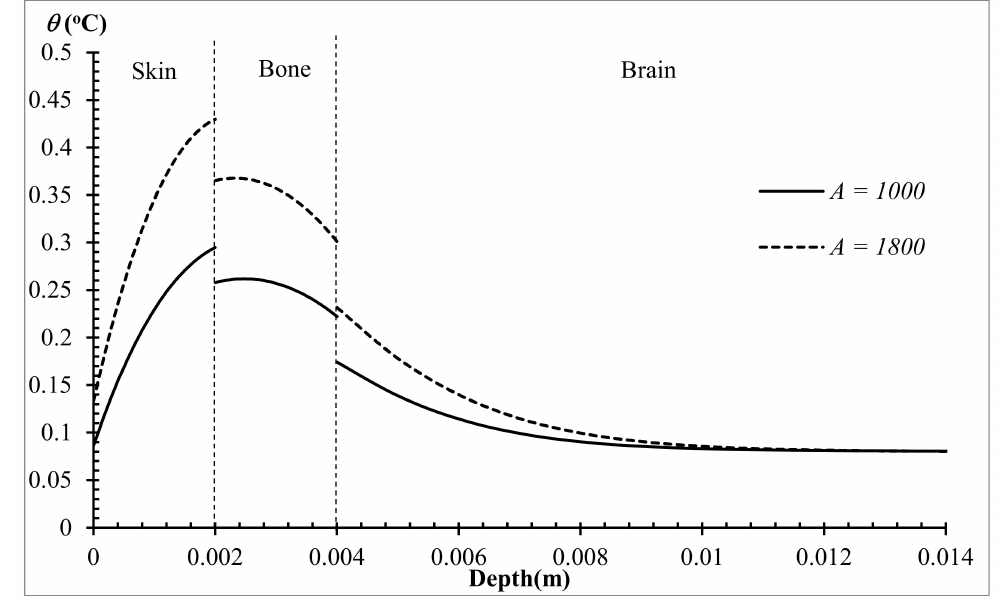
Figure 13. The dynamical temperature increment with different values of power transmission on a child’s